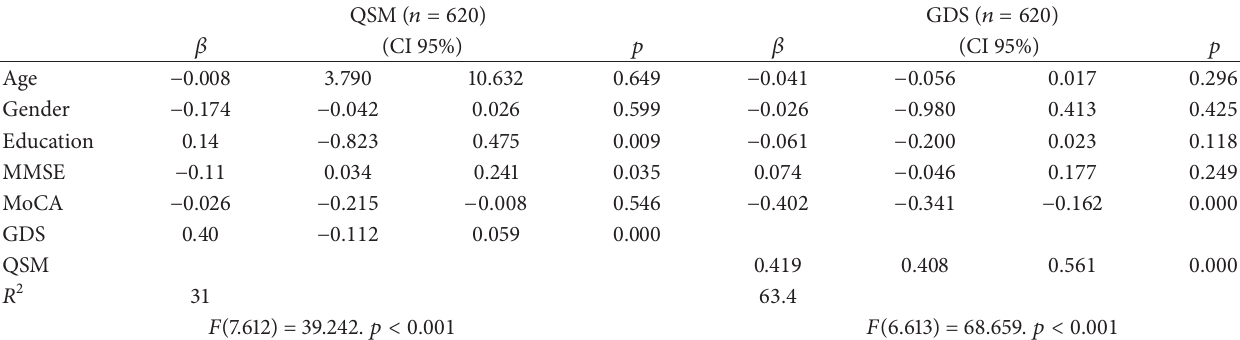
Table 4: Regression analysis of predictors of SMC and depression